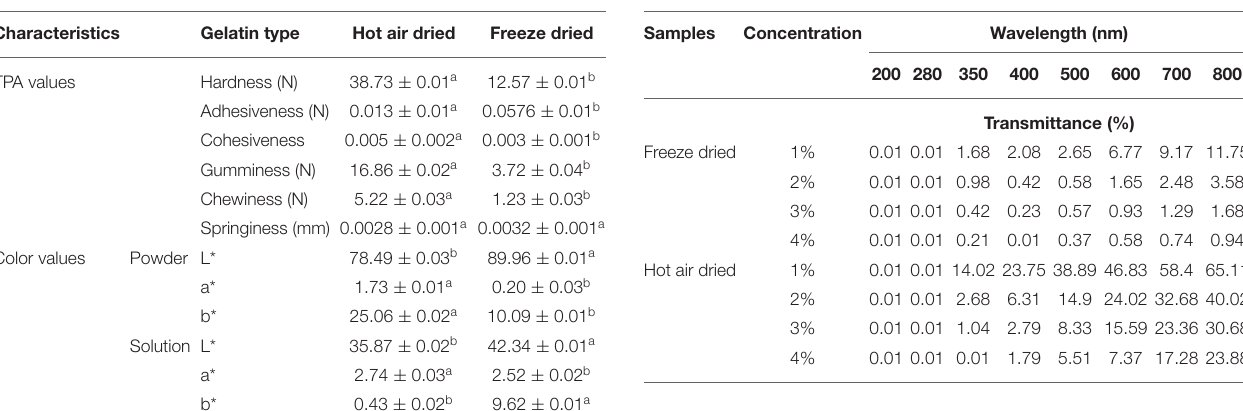
TABLE 3 | Transmittance values of HAD and FD gelatin solutions